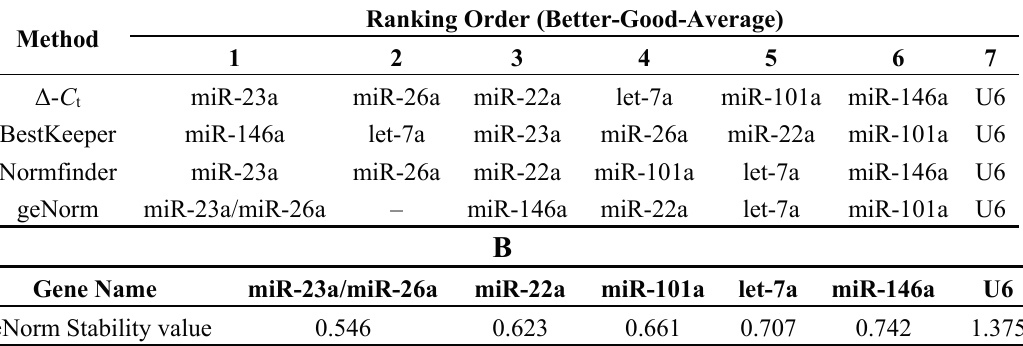
Table 5. Ranking of candidate reference miRNAs and U6 in different post-embryonic developmental